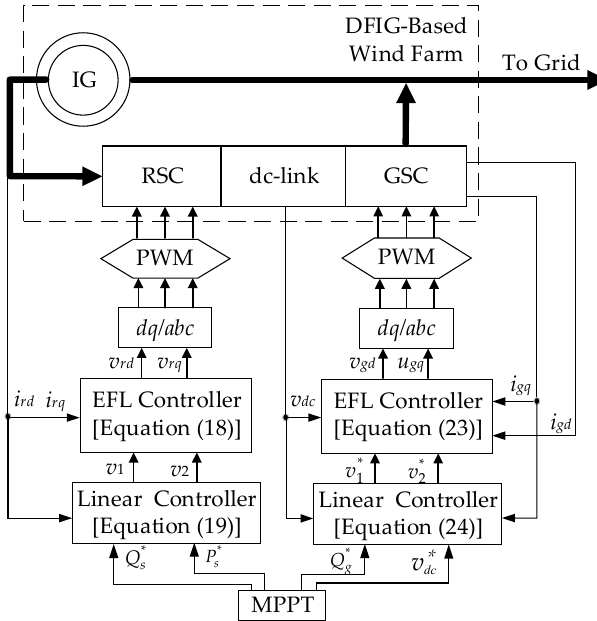
Figure 3. Block diagram of the proposed RSC and grid side converter (GSC) controllers utilizing exact feedback linearization (EFL) method.